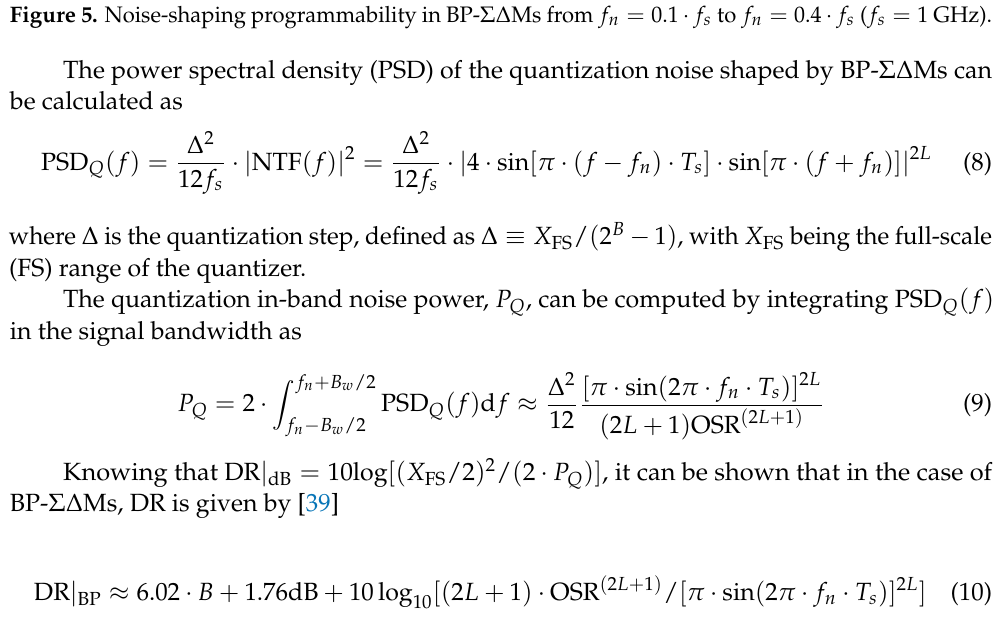
Figure 5. Noise-shaping programmability in BP- Σ∆ Ms from f n = 0.1